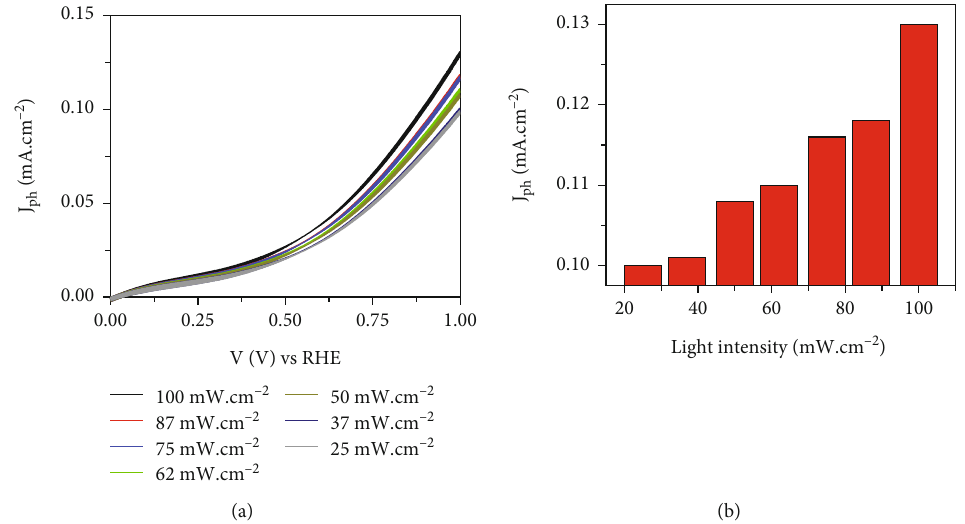
Figure 5: (a and b) The e ff ect of light intensities on the ATO/PANI/PbS electrode for the current density values at 25 °